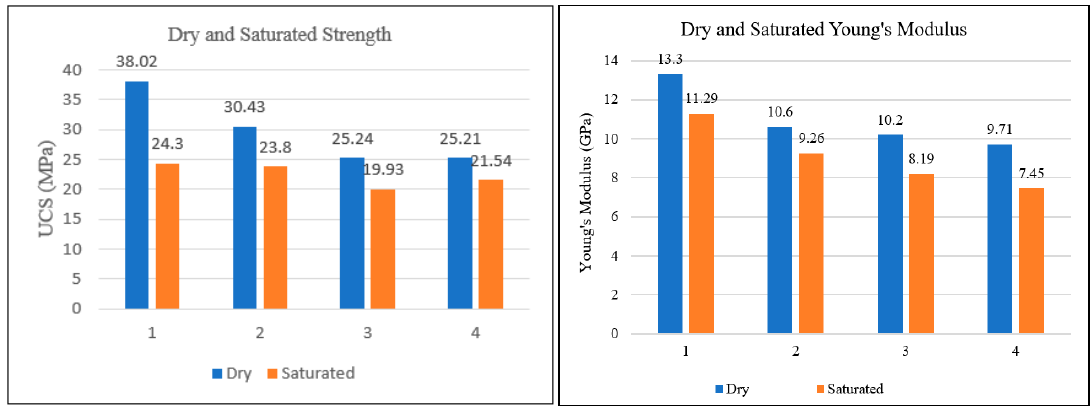
Figure 6. Comparison of uniaxial compressive strength and Young’s modulus for both dry and saturated